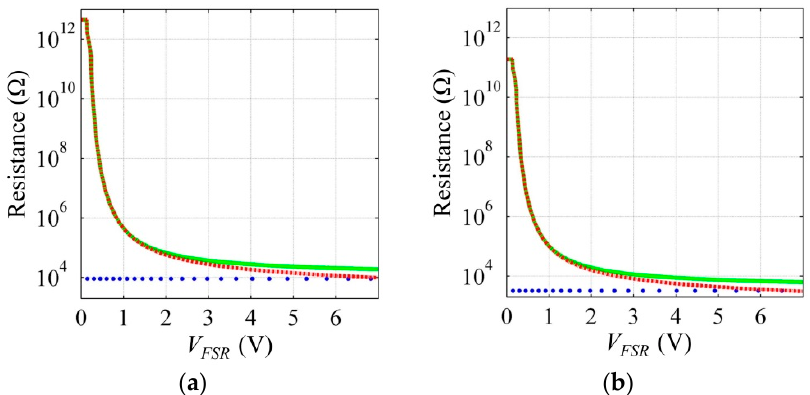
Figure 2. The simulation plot of R FSR (solid green), R bulk (dashed red), and R c (blue points) as a function of V FSR for two mechanical loads of ( a ) σ = 50 kPa and ( b ) σ = 500 kPa. The simulation is obtained for the FlexiForce A201-1 sensor from experimentally-measured parameters [19] and Equations (2)–(8).